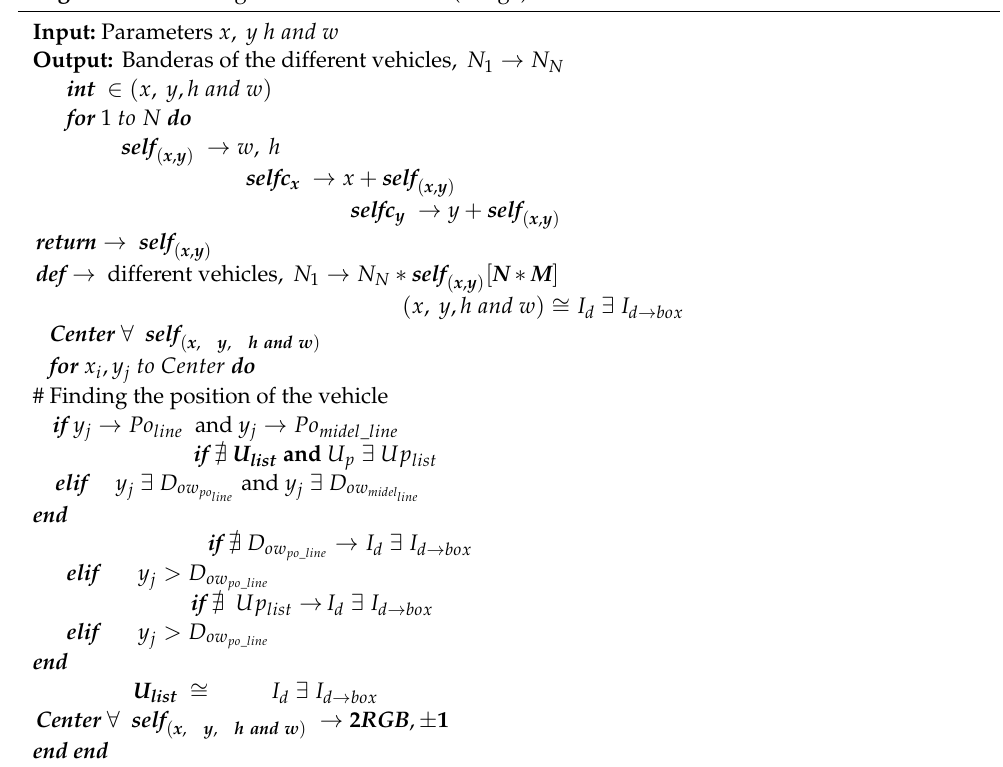
Algorithm 1: Finding the left of the frame (image).